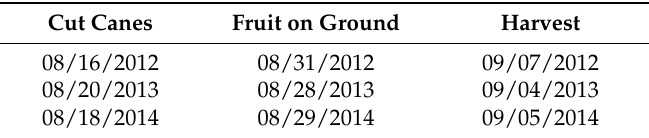
Table 1. Dates for cutting canes, laying fruit on continuous paper tray and harvest (picking fruit off the continuous paper tray) at Caruthers, California field